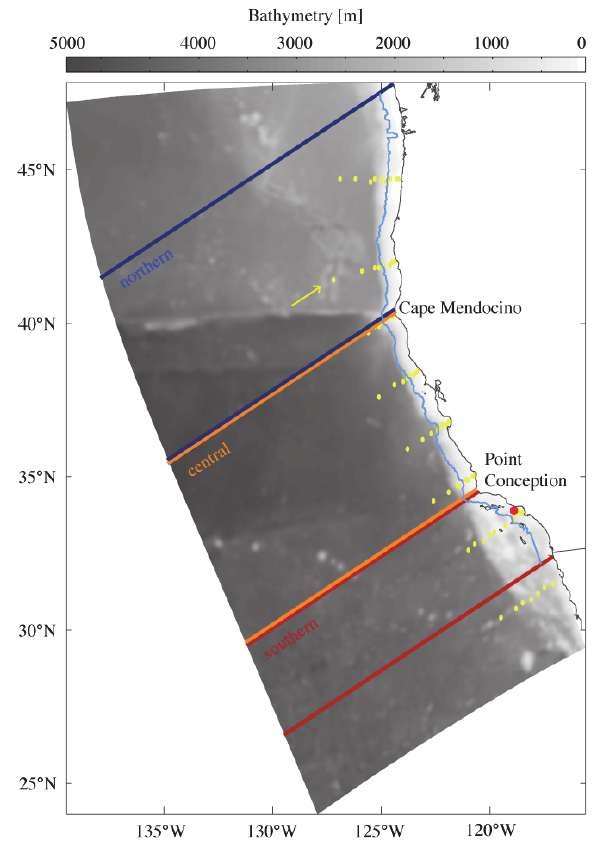
Fig. 1. Map of the domain of the US West Coast configuration of ROMS. The northern subregion is defined by the dark blue box and represents the area between the northern boundary of 47.5 ◦ N and a southern boundary at Cape Mendocino (40.5 ◦ N). Between Cape Mendocino and Point Conception (34.5 ◦ N) the central sub- region is defined by the orange box. The southern subregion extends southwards from Point Conception to 32.4 ◦ N. The light blue line defines the study area of 50km along the coast. Because of the perpendicular orientation of the regional boundaries, the offshore part of each region’s lower boundary lays south of the above mentioned latitudes. The yellow dots indicate the locations used in the model-observational data spatial comparison (see Sect. 3). The arrow is pointed at the transect used for visual comparison. The Santa Monica Bay Observatory Mooring (33 ◦ 55.9 0 N and 118 ◦ 42.9 0 W) is shown as a red dot.